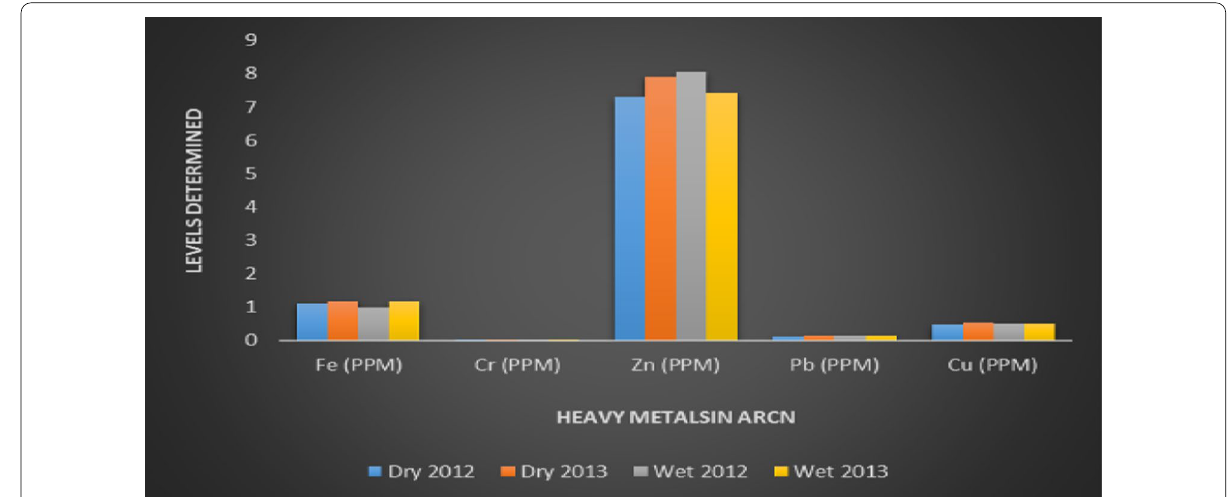
Fig. 10 Seasonal variations in heavy metals in C. nigrodigitatus collected from Asejire Reservoir